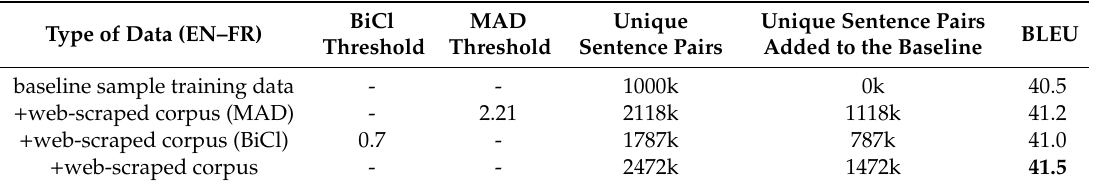
Table 6. Extrinsic evaluation of MAD and BiCleaner (EN–FR), with highest score shown in bold. Type of Data (EN–FR)